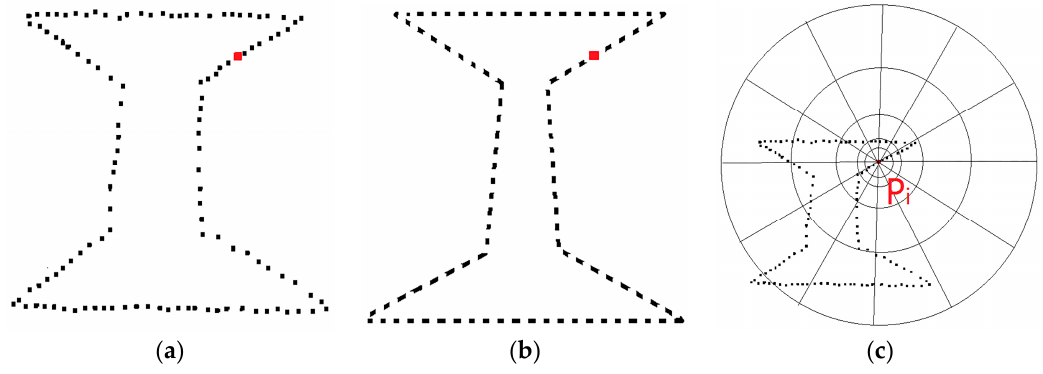
Figure 8. Point sampling and its shape context for pylon head type recognition: ( a ) the sampled edge of pylon head point; ( b ) the sampled edge points of head model; and ( c ) the target template used to compute the shape context of point p i .